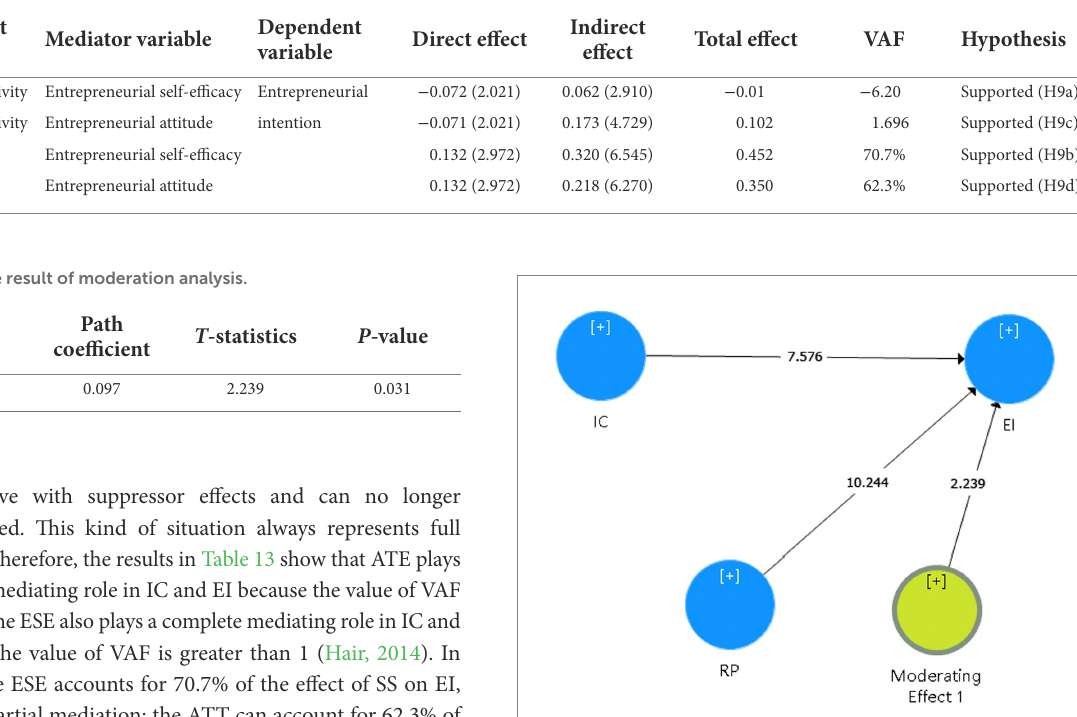
FIGURE 4 The moderating role of risk